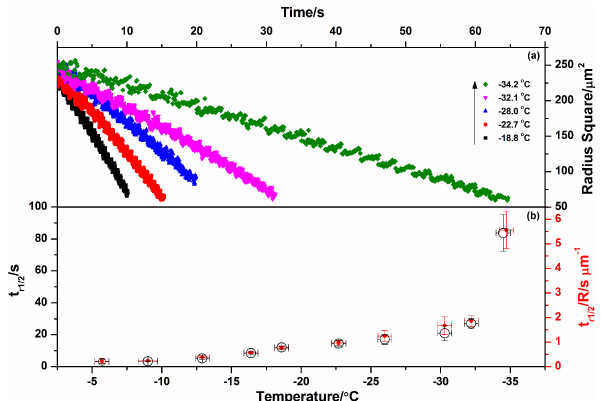
Figure 4. (a) Example evaporation decay traces of SWDs at five dif- ferent subzero temperatures. (b) t r 1 / 2 of SWDs at 10 different tem- peratures (black circles), and the ratio of t r 1 / 2 to radius ( t r 1 / 2 /R ) estimated for the change of SWDs for a series of temperature mea- surements (red dots). The temperature error is the value stated by the manufacturer. The y error for the t r 1 / 2 and t r 1 / 2 /R is the standard deviation of the measurement. At least three individual experiments at each temperature were